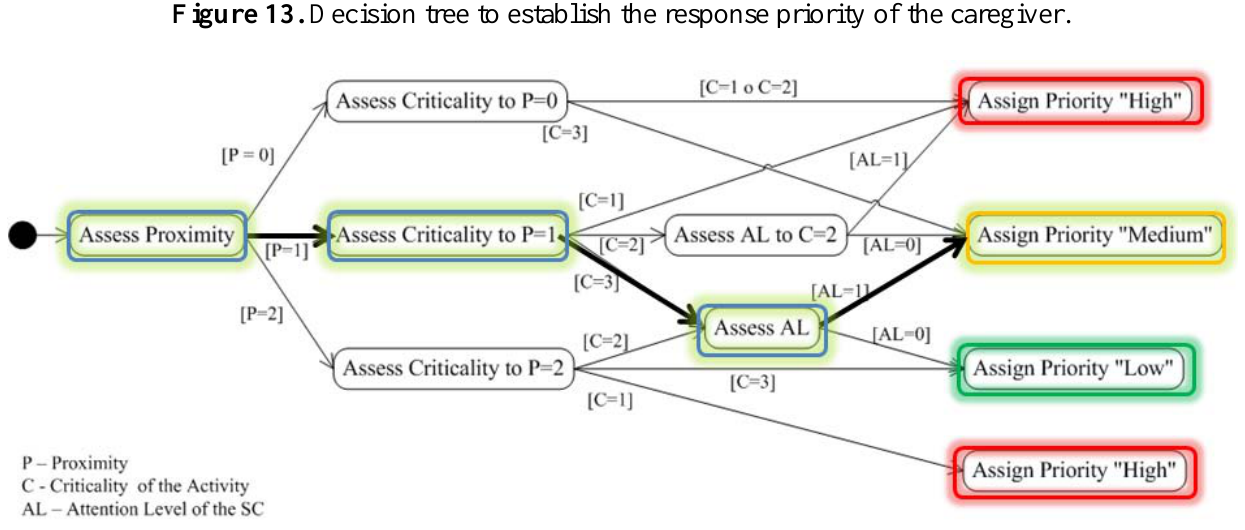
Figure 13. Decision tree to establish the response priority of the